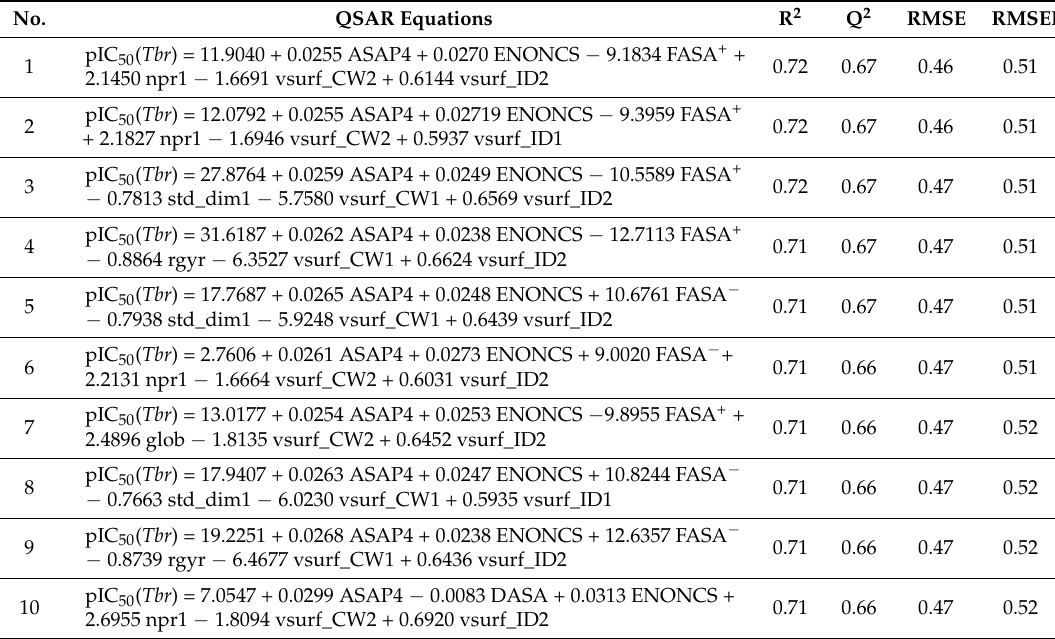
Table 1. The 10 best GA/MLR QSAR equations obtained in Model 1.